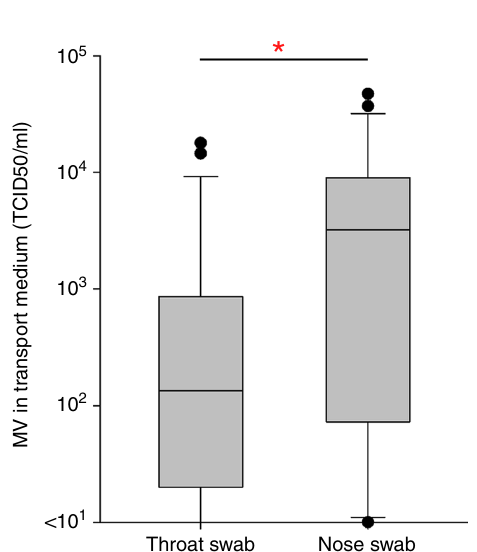
Fig. 2 MV titres detected in transport medium of throat and nose swabs collected from early acute measles patients in Cohort A ( n = 23). Centre lines of the box plots represent medians. Lower and upper boundaries of the boxes represent fi rst and third quartiles, respectively. Lower and upper whiskers represent the 10th and 90th percentiles of the data, respectively. Dots represent outliers. Statistical analysis was performed using Mann – Whitney rank sum test. * P < 0.05